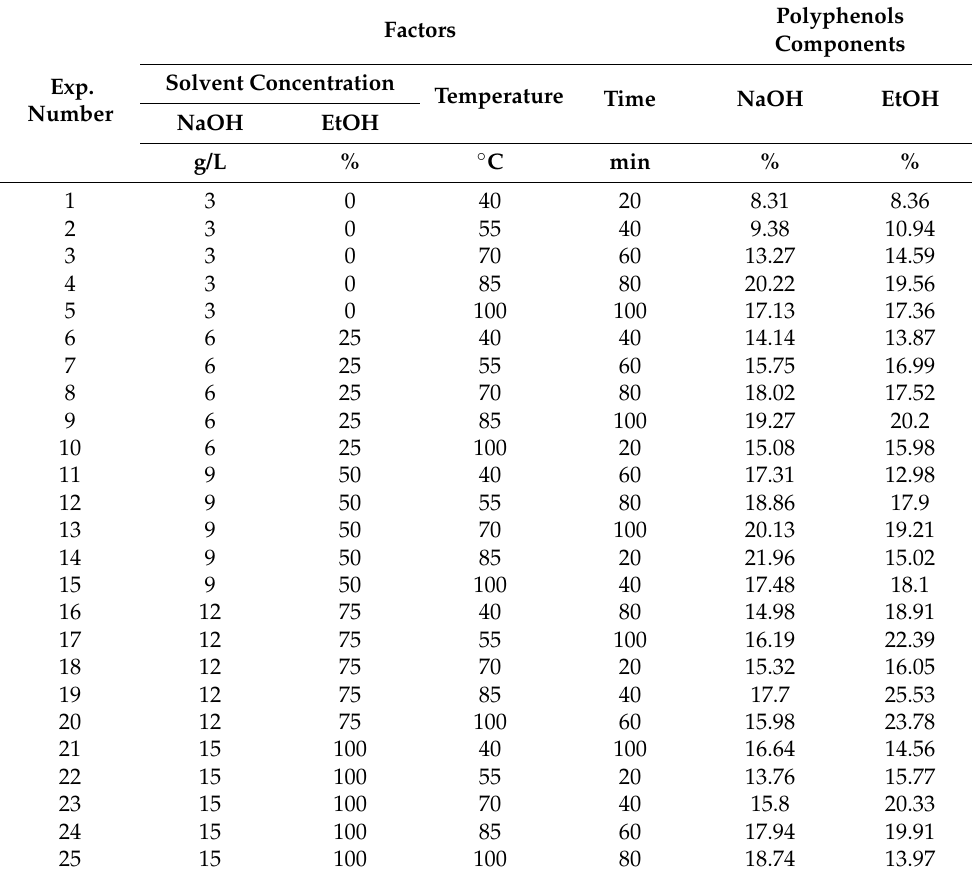
Table 4. Taguchi DOE with Factors and obtained response for NaOH and EtOH solvent systems.